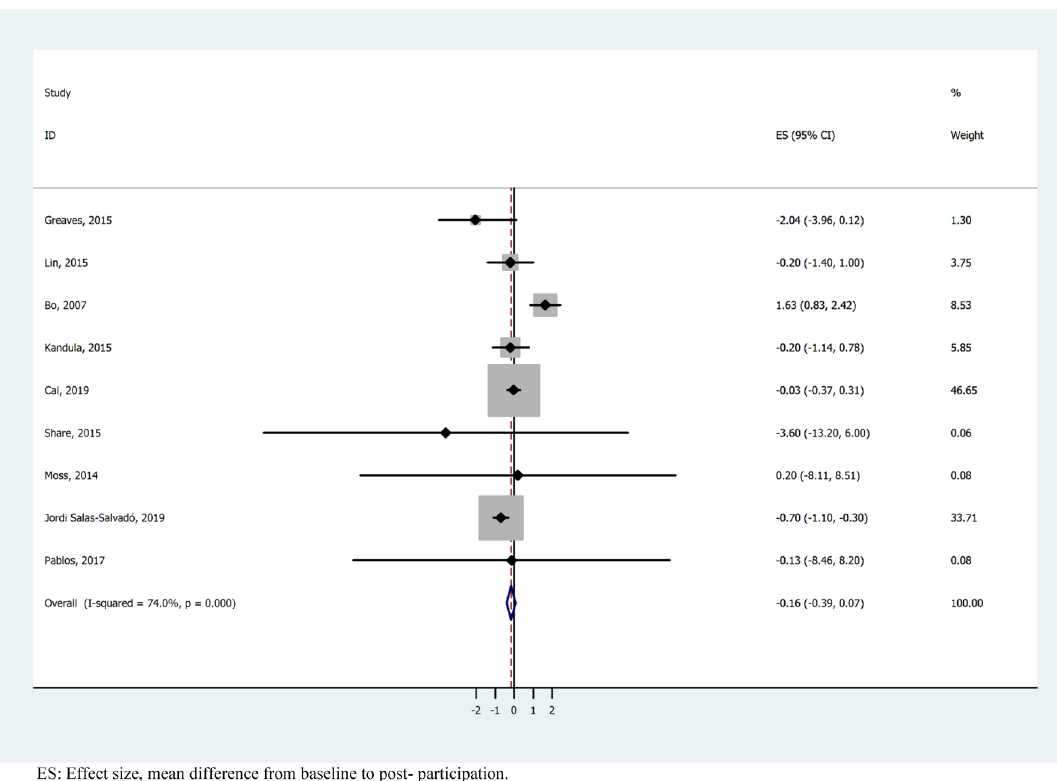
Figure 5. Meta-analyses of weight loss outcome in control group participants stratified by high-quality lifestyle randomized controlled